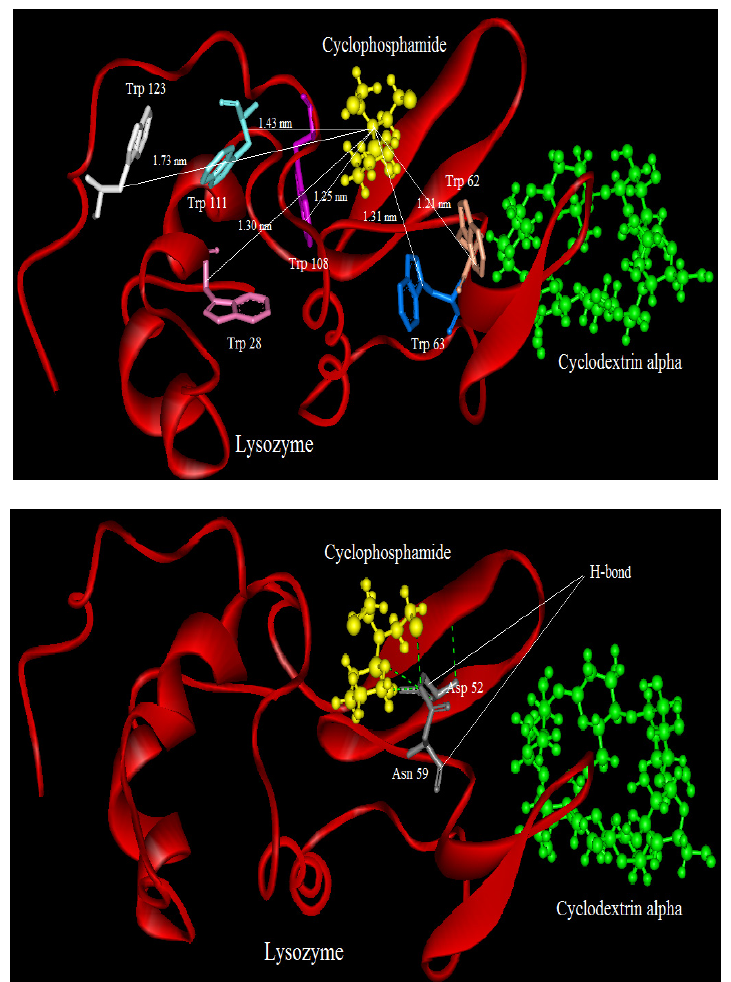
Figure 11. Distance between CYC and Trp residues in ternary system and in the presence of CD( α ); below: show the number and type of amino acids involved in the hydrogen binding between LYZ and CYC in presence o of CD( α